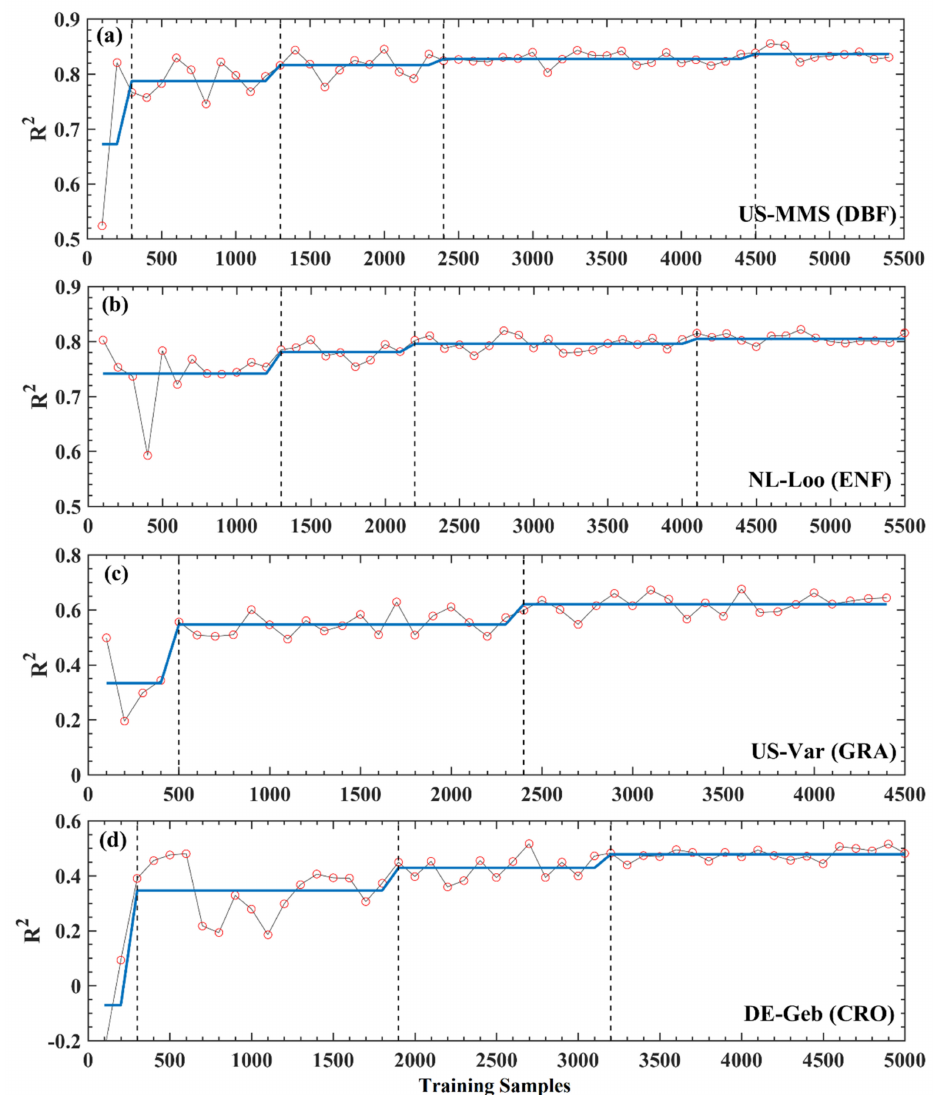
Figure 5. Mutation detections for the evaluation results of XGBoost in Figure 4e–h by the BG segmentation algorithm. The black vertical dash lines represent mutation